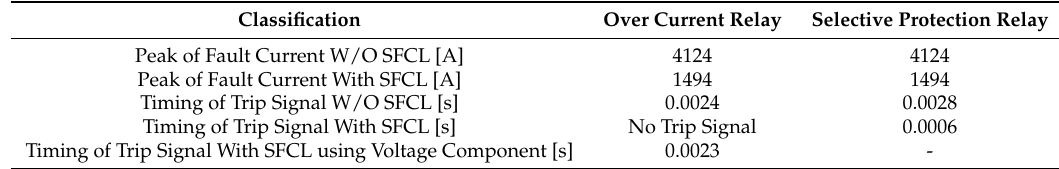
Table 4. Simulation